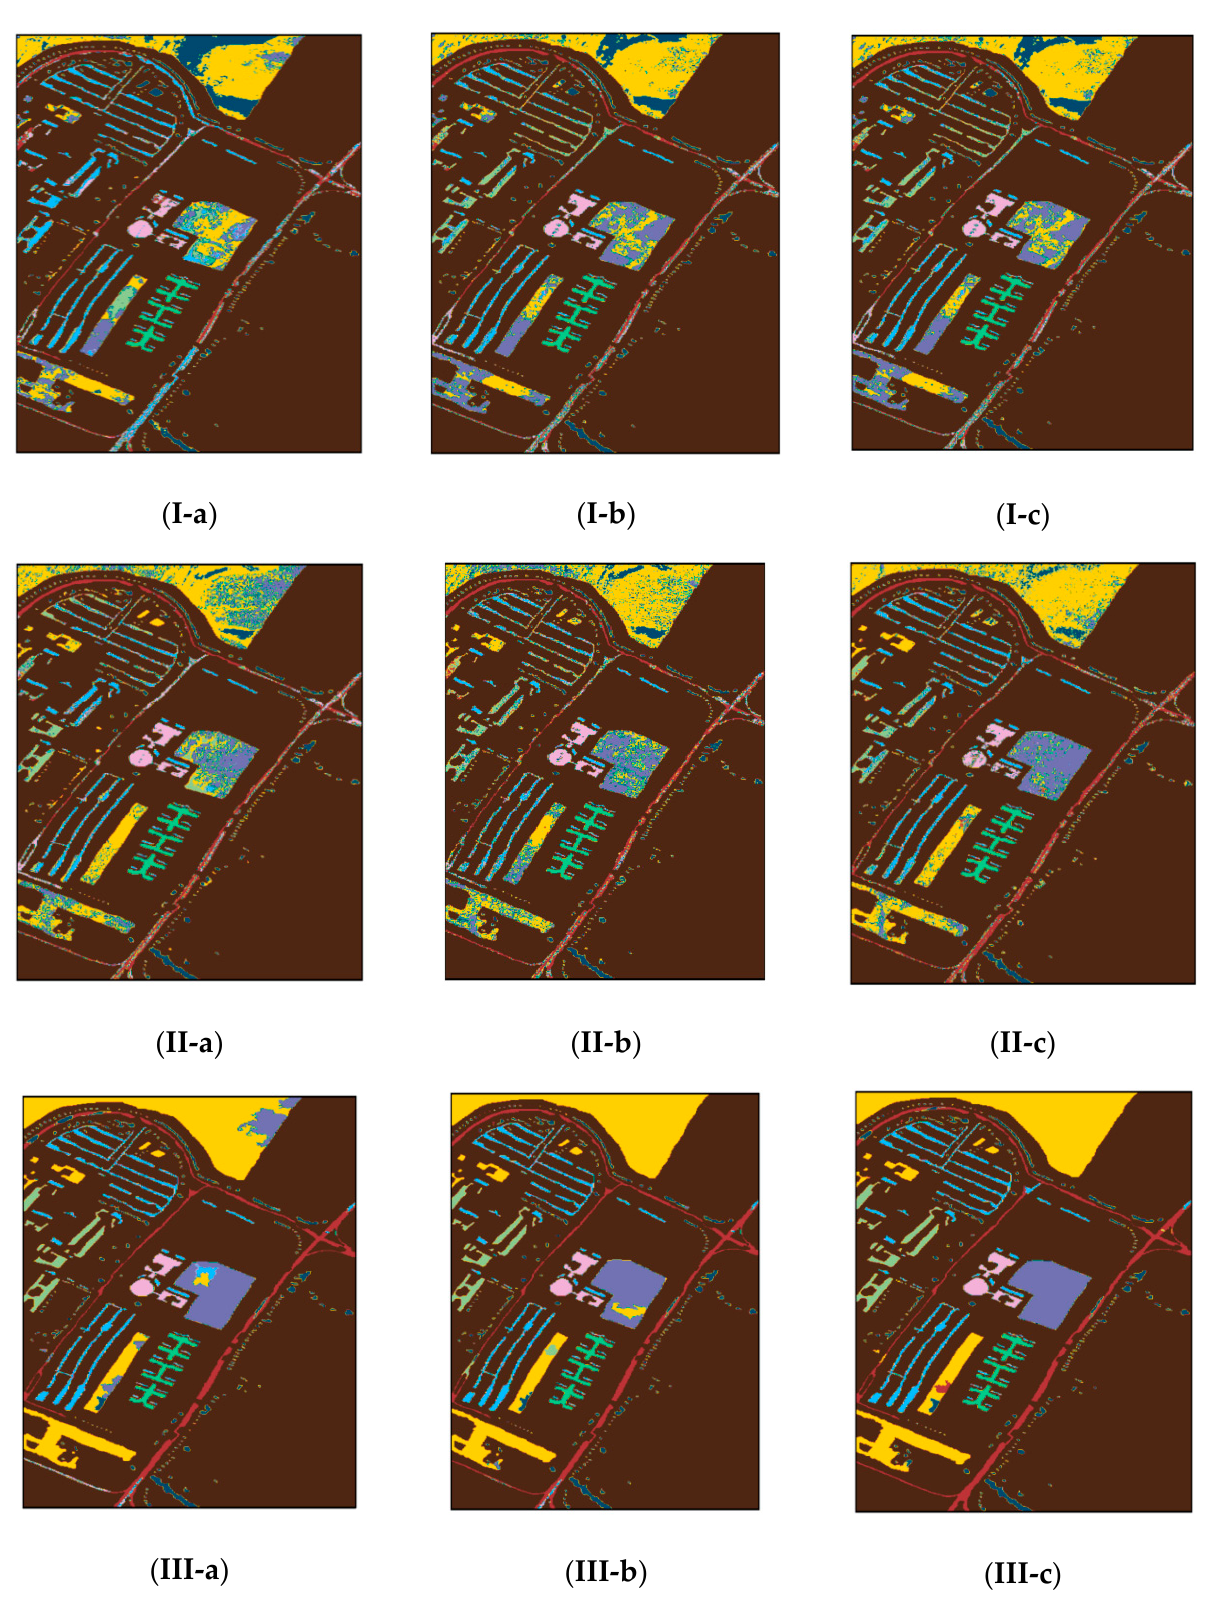
Figure 6. PaviaU classification results. ( a ) KNN. ( b ) SVM. ( c ) Proposal. ( I ) Training sample 10. ( II ) Training sample 30. ( III ) Training sample 50.